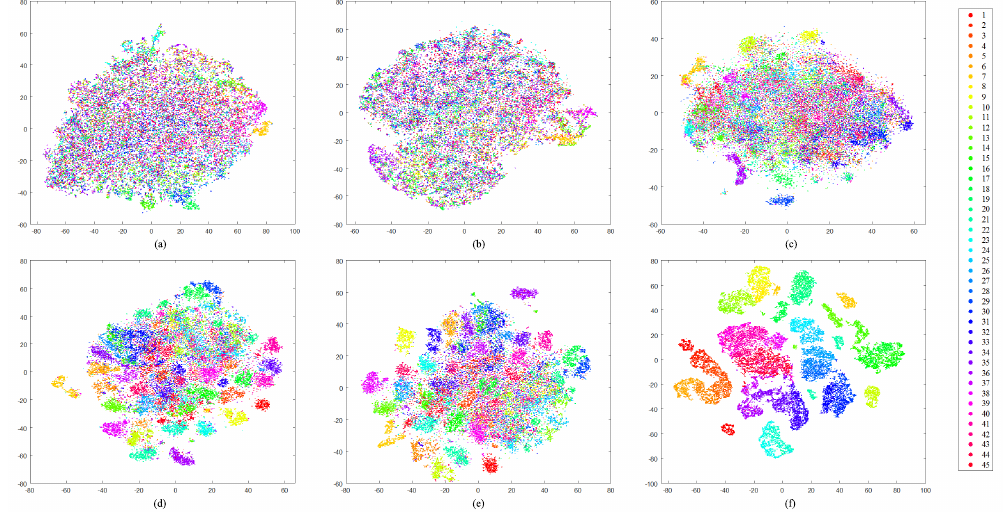
Figure 16. Two-dimensional scatterplots of different high-dimensional features obtained by t-SNE over ImgDB4 with 45 semantic classes. The relationships between number ID and semantics can be found in Figure 12. ( a ) HT; ( b ) CH; ( c ) S-BOW; ( d ) DN-7; ( e ) DN-8; ( f )